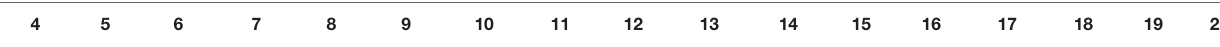
TABLE 2 | Bivariate correlations among primary study variables and potential